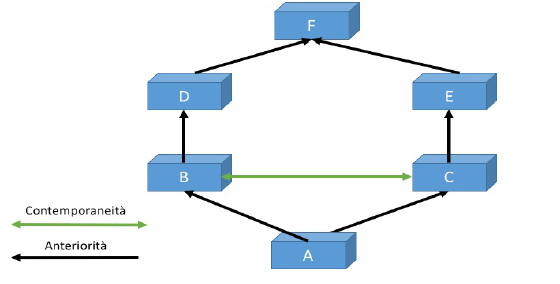
Figure 7. Example of relations between US .